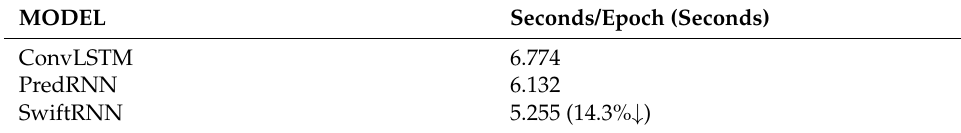
Table 8. Model training speed.